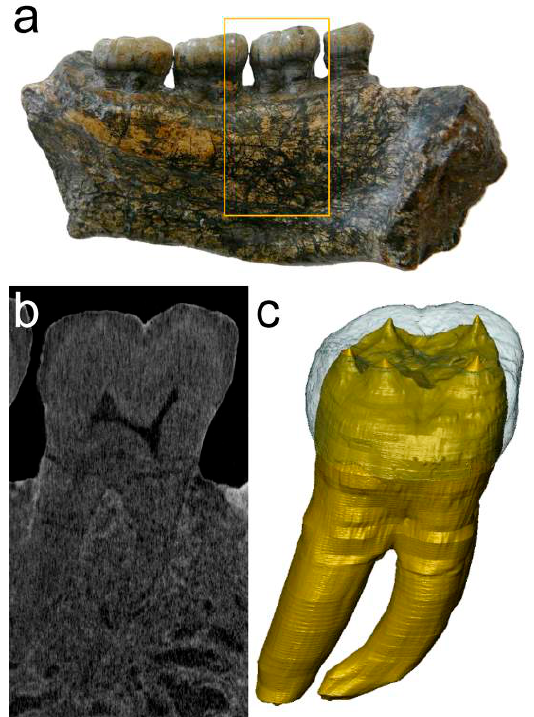
Figure 7. In mandibular specimens ( a ), due to fossilization, we sometimes obtained noisy datasets ( b ), but it was still possible to retrieve reliable morphological information on the internal tooth structure ( c ) [11] (with permission).